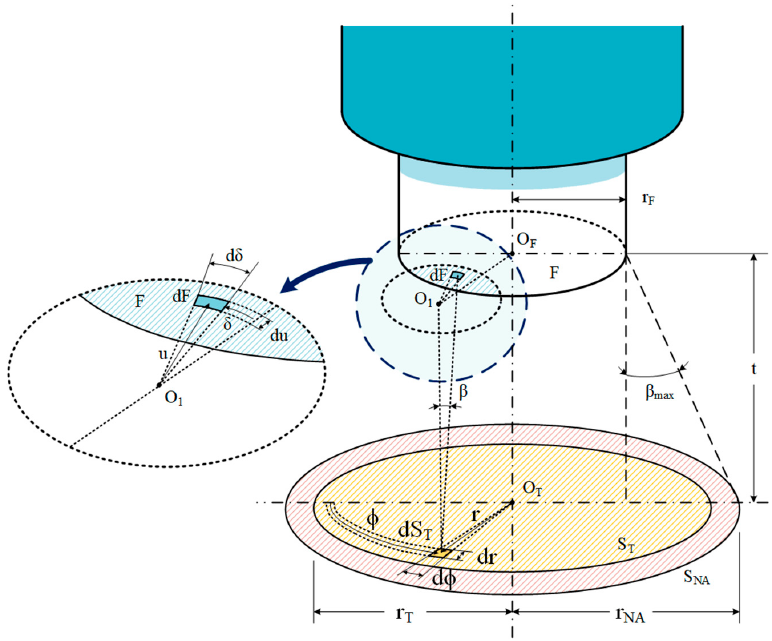
Figure 1. Set up of the target surface, variables and the optical fiber of the pyrometer. Adapted from [37].